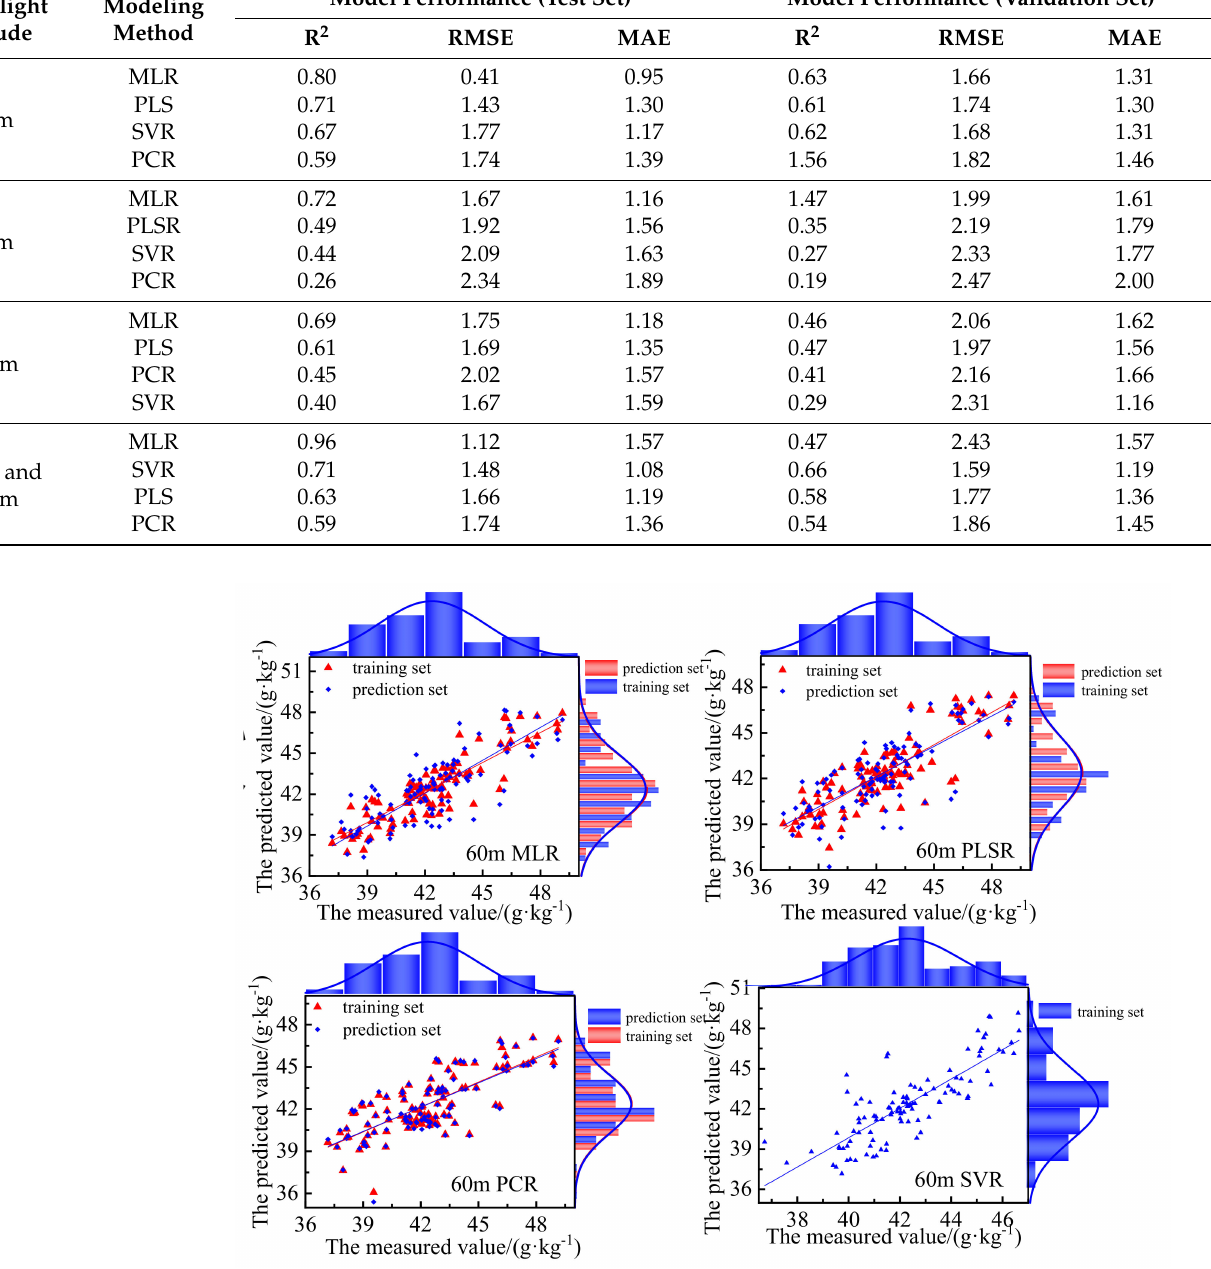
Figure 14. Scatterplots of the measured LNC vs. predicted LNC using multiple modeling methods (60